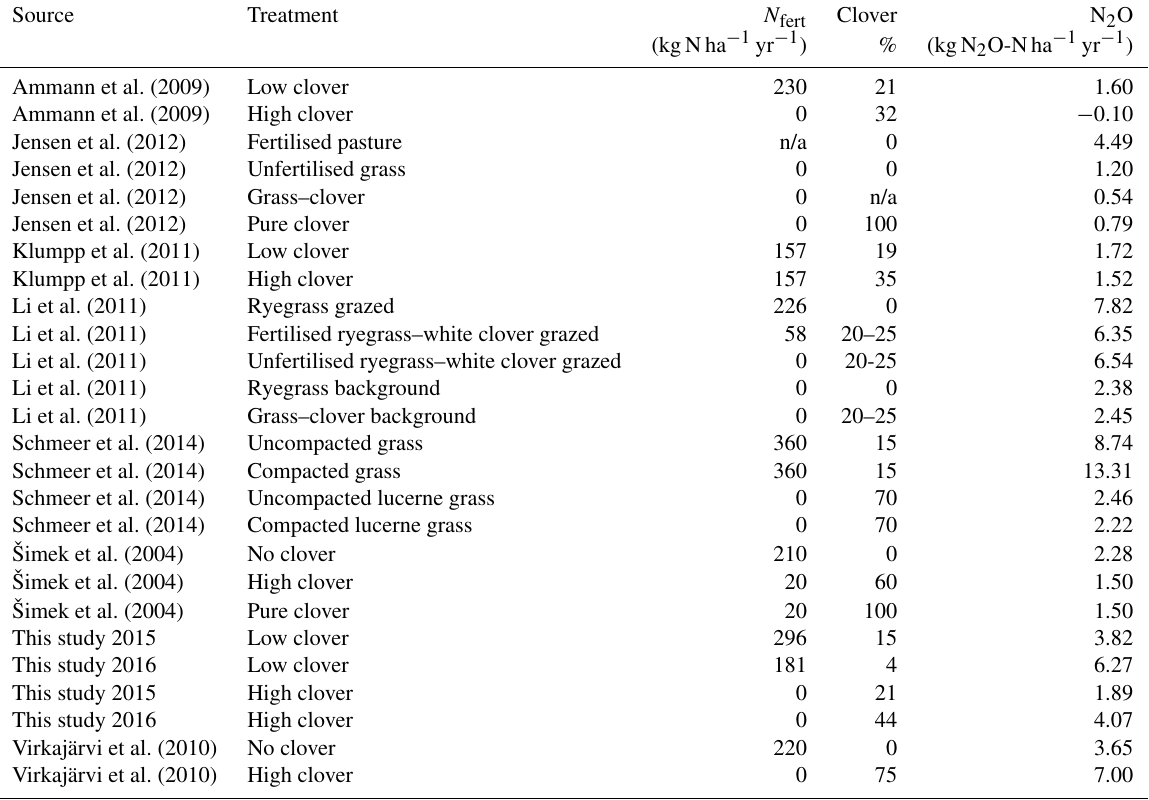
Table 5. Summary of studies investigating N 2 O emissions simultaneously in permanent grasslands of at least two different clover proportions. We included studies with > 200 days of temporal coverage and at least biweekly sampling of N 2 O emissions or, if discontinuously sampled, included a sensible strategy used by the authors in order to estimate annual